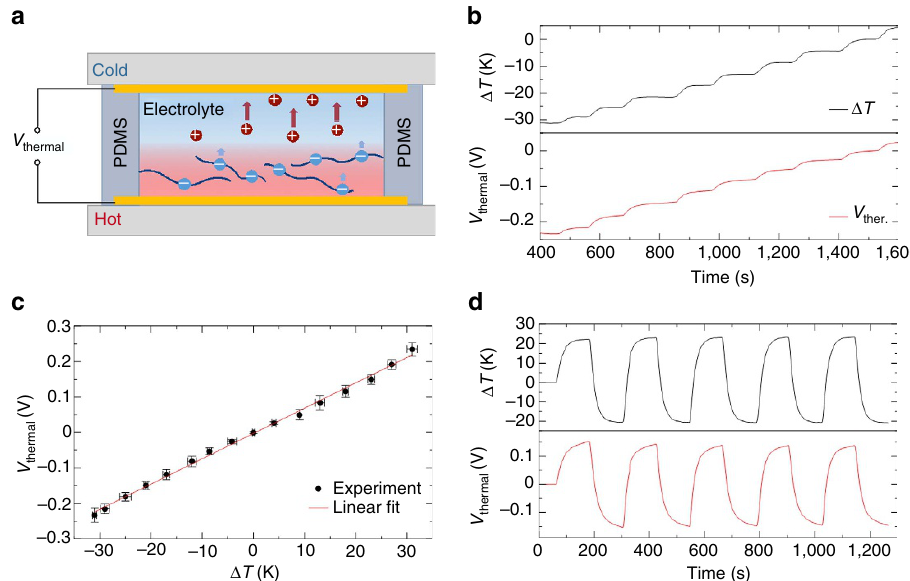
Figure 2 | Electrical characteristics of the ionic thermoelectric voltage generators. Schematic diagram of the ITESC. Positive charges are mobile Na þ cations, while negative charges are immobile alkoxylate and carboxylate anions ( a ). Measured V thermal and D T between the two Au electrodes ( b ). Linear fitting of V thermal with different D T values. For each point, D T is fixed until V thermal was stable. The slope of the linear fit to the data gives a Seebeck coefficient of 7mVK (cid:2) 1 . ( c ) The error bar represents the fluctuation of D T and V thermal at each point. Switching characteristics of the device showing a response time of 25s (50s) for 70% (90%) of the saturated voltage ( d ).